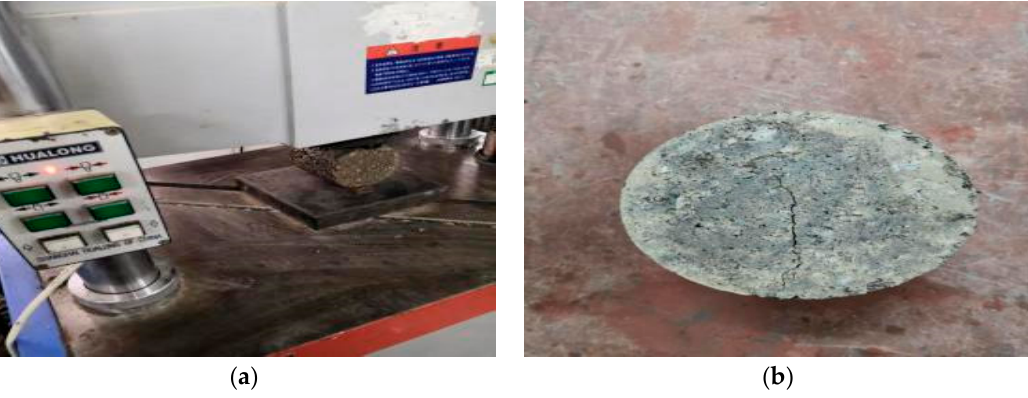
Figure 6. Splitting strength test: ( a ) In test; ( b ) After test.